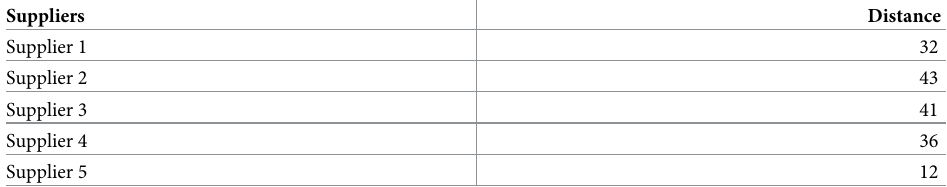
Table 9. Distance between suppliers and buyer in Km.